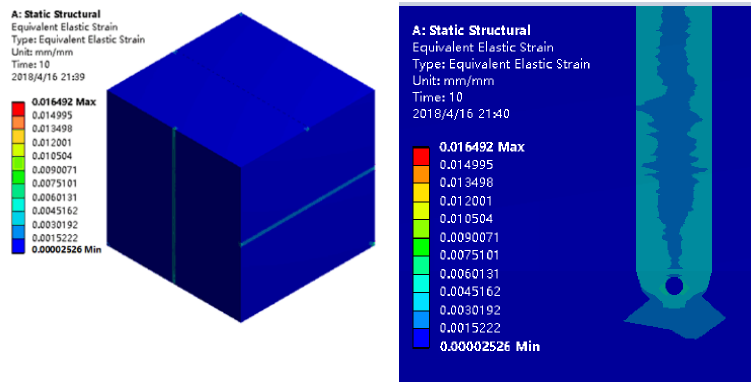
Figure 7. The equivalent strain of the sensor under 50 MPa uniaxial load.